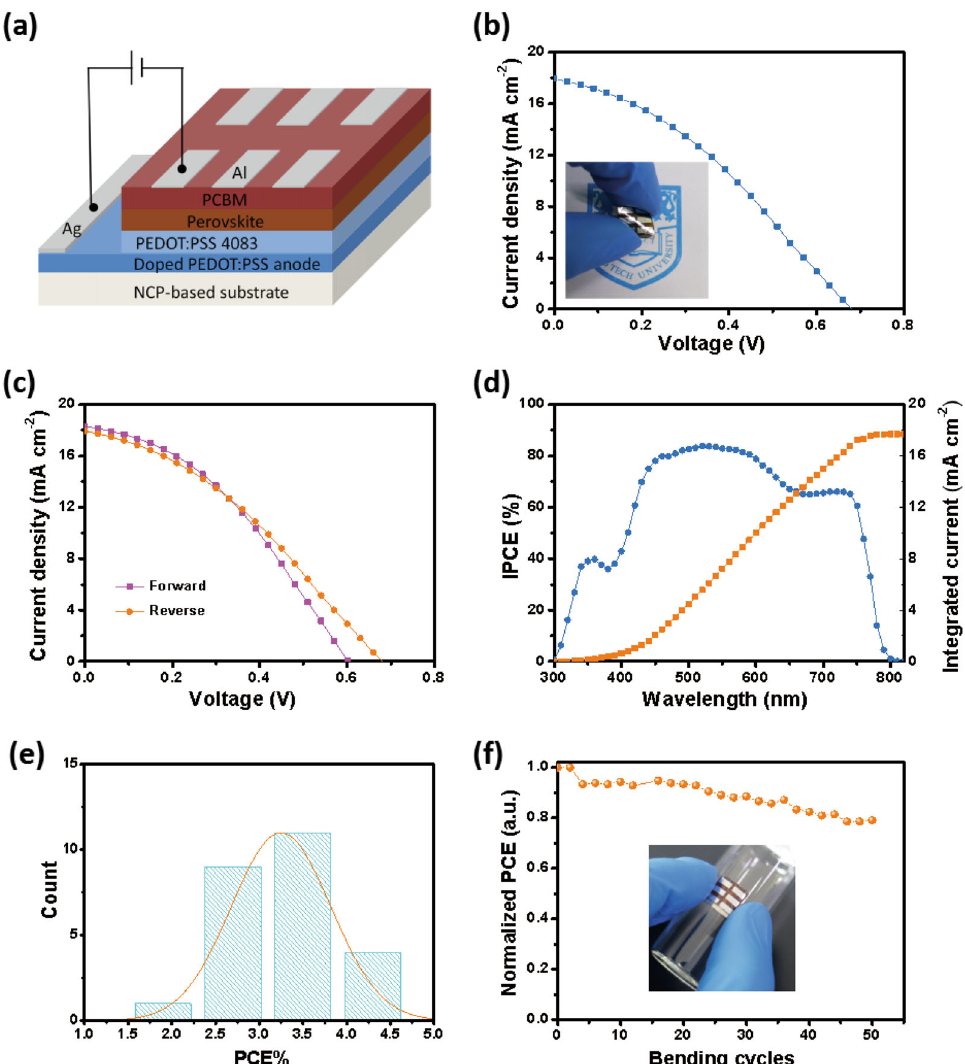
Fig. 4 Device performance of NCP-based PSCs. a The device structure of perovskite planar heterojunction solar cells. b Current density- voltage (J-V) characterization of MAPbI 3 devices. Inset: a digital photograph of NCP-based PSCs in bending state. c J-V curves under reverse and forward scanning directions. d IPCE of best-performing device and the integrated current densities obtained from the IPCE spectra. e PCE histogram of 25 devices fi tted with a Gaussian distribution. f Normalized PCE-bending cycles characterization. Inset: a digital photograph of bending state by hand on a glass bottle with a diameter of 15